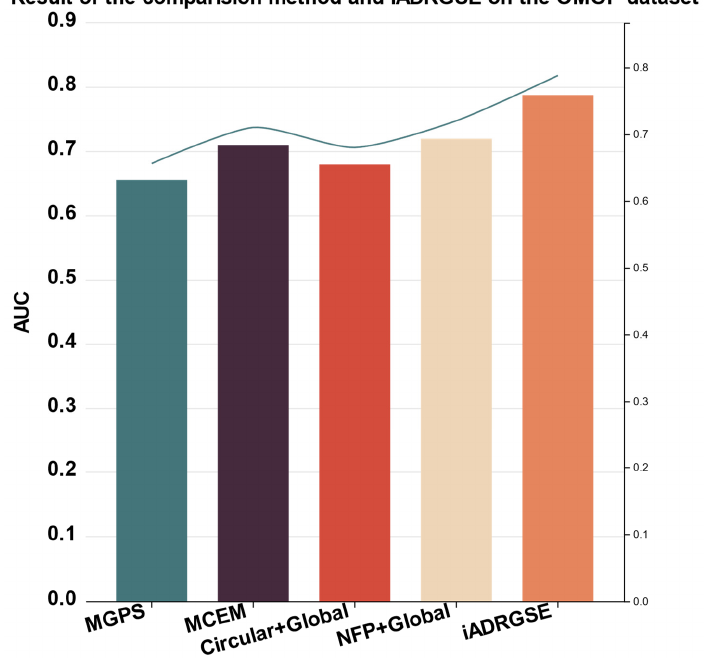
Figure 2. Results of the comparison method and iADRGSE on the OMOP dataset.